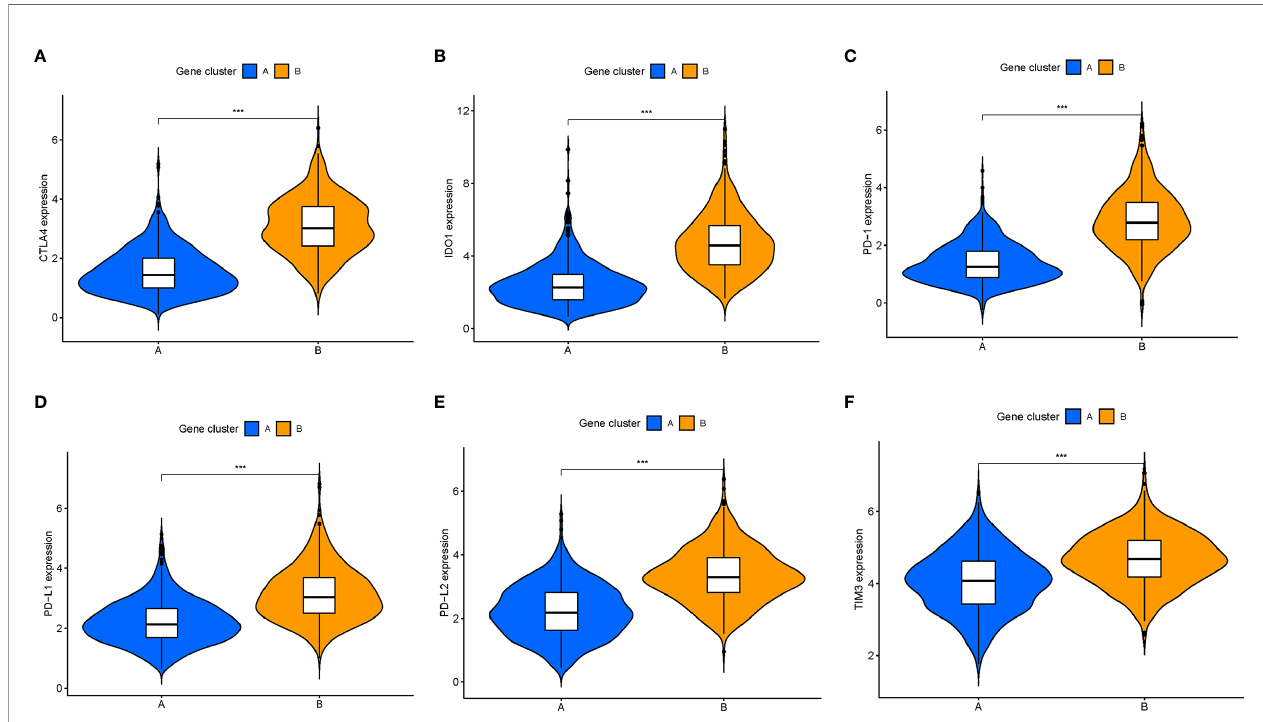
FIGURE 5 | Comparison of ICB-relevant key genes among distinct ICI gene clusters. The expression levels of CTLA4 (A) , IDO1 (B) , PD1 (C) , PD-L1 (D) , PD-L2 (E) , and TIM3 (F) of patients from distinct ICI gene clusters. The asterisks represented the statistical p value (***P <